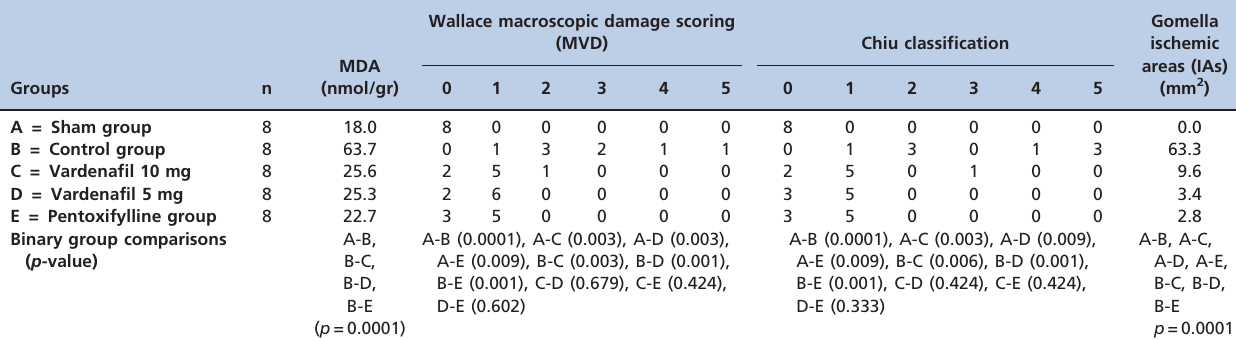
Table 3 - Comparisons of MDA, Wallace macroscopic damage scores and Chiu classification in